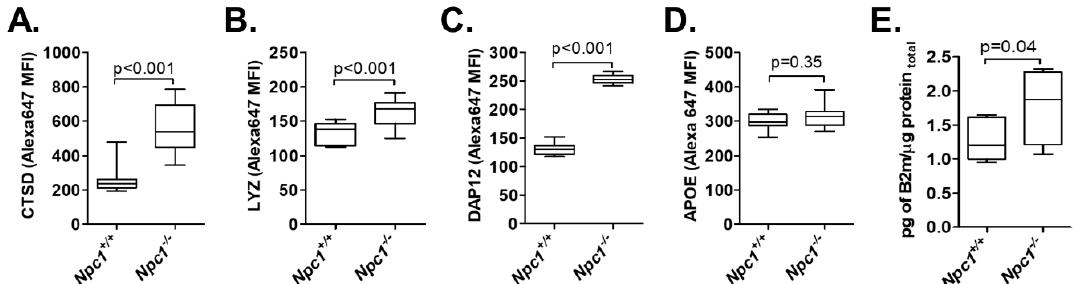
Figure 6. Protein validation of selected differentially expressed transcripts identified in 7-week old Npc1 −/− cerebella. Immunohistochemistry quantification of cathepsin D ( A ), lysozyme ( B ), DAP12 ( C ), and apolipoprotein E (APOE) ( D ). Representative examples of cerebellar staining are provided in Figure S6. β2 microglobulin ( E ) was quantified by ELISA. N >